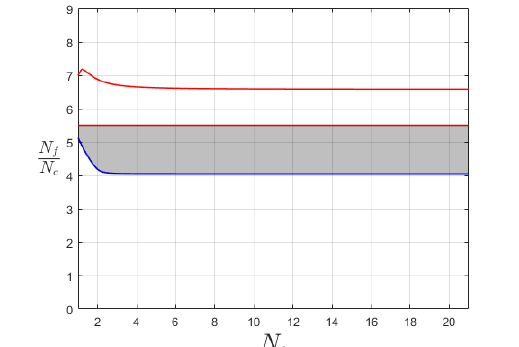
window with completely stable Banks-Zaks (cid:12)xed point. Figure 16. Two options for the conformal window. Blue lines: lower edge of the conformal window through annihilation of the Banks-Zaks (cid:12)xed point with another (cid:12)xed point QCD*. Lower red line: upper edge of the conformal window, where the Banks-Zaks (cid:12)xed point obtains non-trivial positive gauge coupling. Upper red line: line where the QCD* theory obtains a non-trivial positive gauge coupling. Shaded region: conformal window. Light shaded region: region where the Banks-Zaks and the QCD* (cid:12)xed point diverge instead of